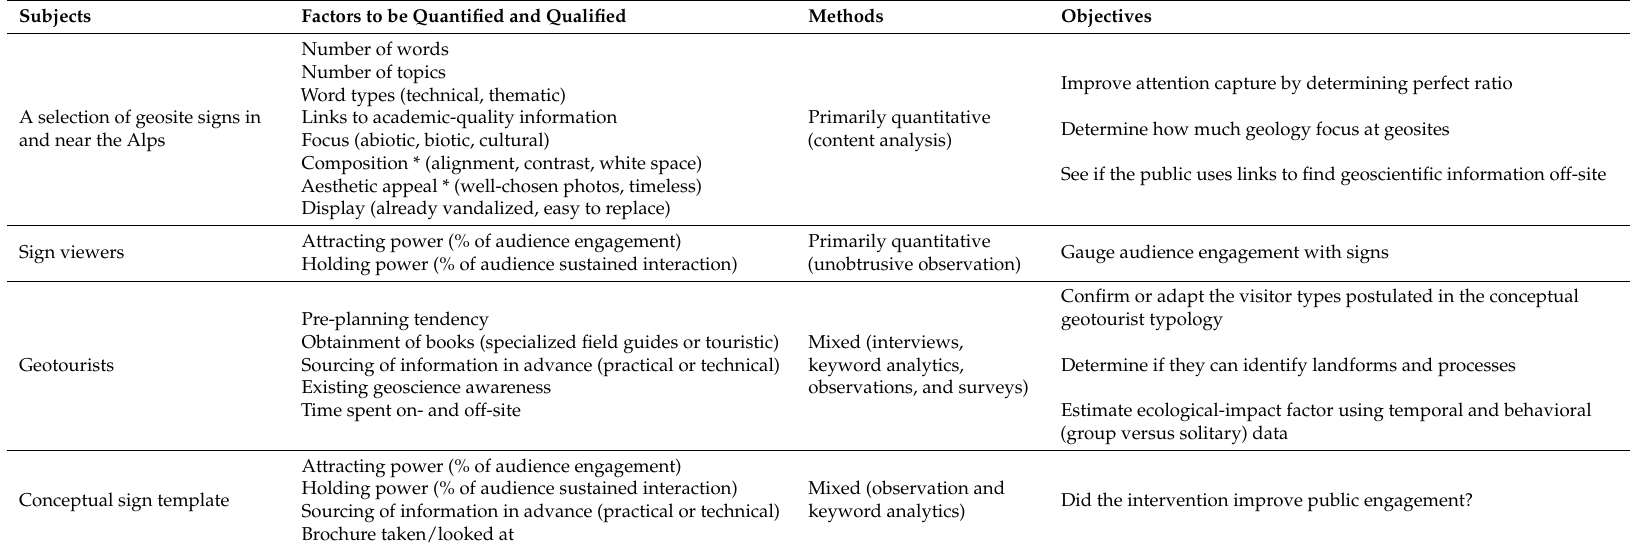
Table A2. Preliminary Data Collection Plan to Test Existing Signs and the Tools Being Developed to Check Their Attracting and Holding Power and Facility to Appeal to a Broad Audience. Conceptual Geotourist Categories Will Also be